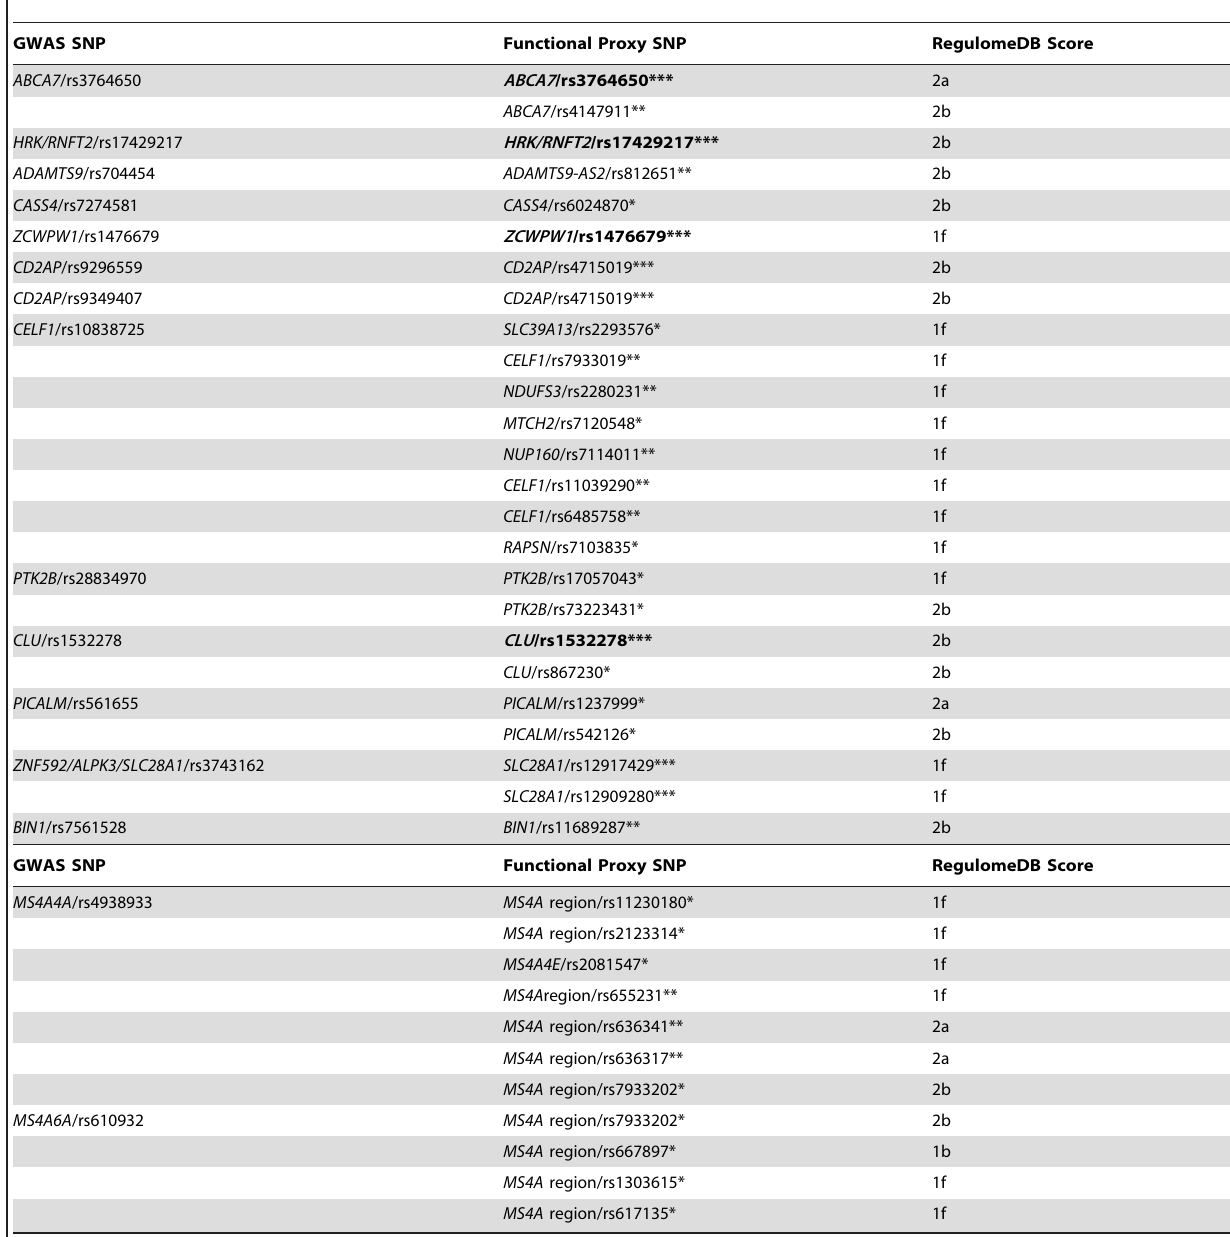
Table 4. Linkage disequilibrium for published GWAS SNPs with functional proxies (RegulomeDB score , 3) according to SNAP